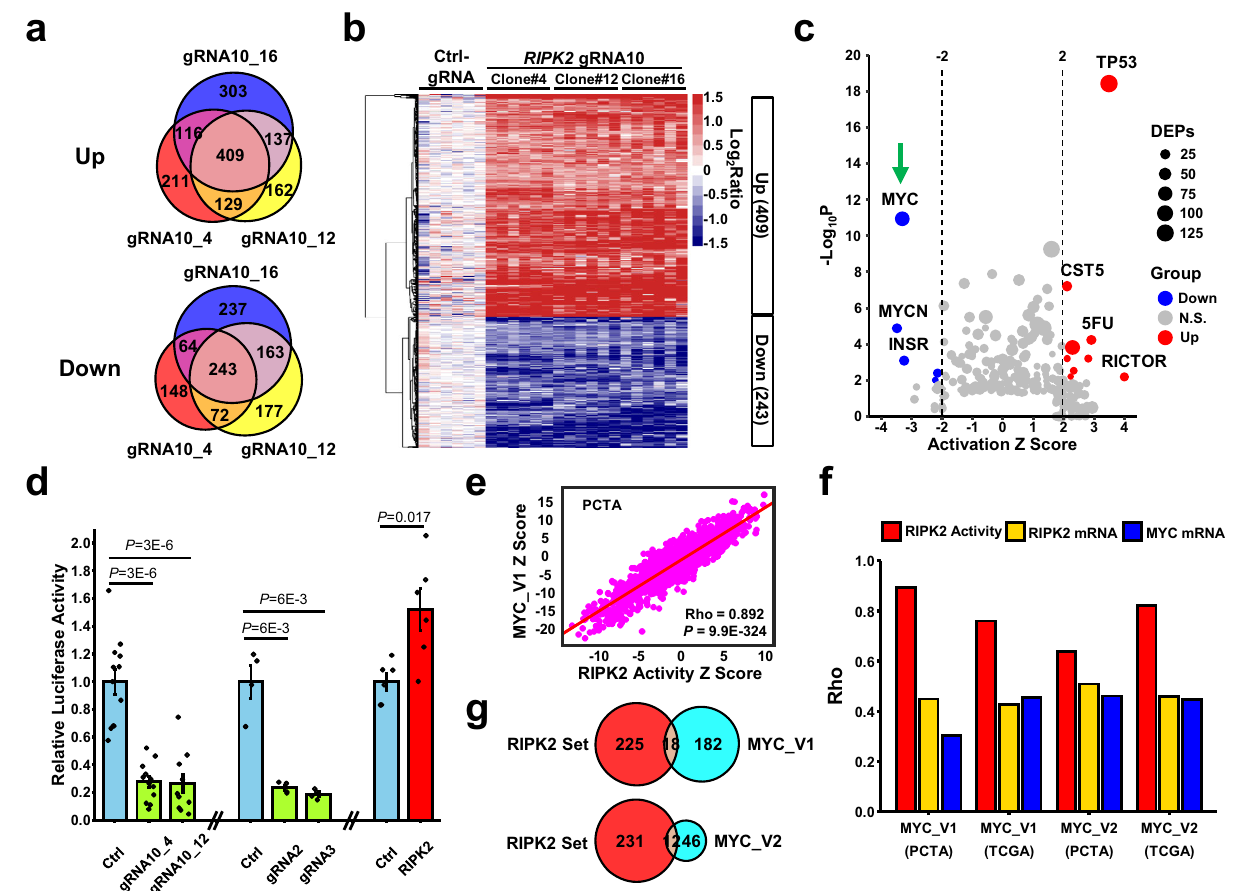
Fig. 3 Label-free proteomics reveals RIPK2 as a potent activator of c-Myc. a Venn diagrams of protein groups that are upregulated (upper) or downregulated (lower) in the three RIPK2 -KO PC3 single-cell clones (#4, #12, and #16), compared with control cells. b Heatmap of the 652 overlapping differentially expressed protein groups in the control or RIPK2 -KO PC3 clones (3 biological replicates × 2 LC-MS/MS runs). c Scatter plot of putative regulators upstream of the 652 differentially expressed proteins. The activation Z scores and p -values were computed by Ingenuity Pathway Analysis. d Bar plot of the relative MYC luciferase reporter activity in PC3 cells under the indicated conditions ( n = 12, 4, and 6 biologically independent samples in the left three, middle three, and right two conditions, respectively). Data are shown as mean ± SEM. e Scatter plot of RIPK2-induced activity Z scores against Hallmark_MYC_Targets_V1 gene-set activity Z scores in the PCTA cohort. f Bar plot of the Spearman ’ s correlation coef fi cients (rho) of RIPK2 -induced activity scores (red), RIPK2 mRNA levels (orange), and MYC mRNA levels (blue) with MYC activity scores (V1 or V2) in the PCTA or TCGA (Firehose Legacy) PC cohorts. g Venn diagram of genes contained in the RIPK2-induced protein signature (i.e., the 243 protein groups downregulated by RIPK2 -KO) and those in the Hallmark_MYC_Targets_V1 (upper) or _V2 (lower) gene set. Nominal p- values were determined by two-sided Fisher ’ s exact test ( c ), unpaired two-tailed Student ’ s t -test ( d ), or using a t -distribution with n -2 degrees of freedom ( e